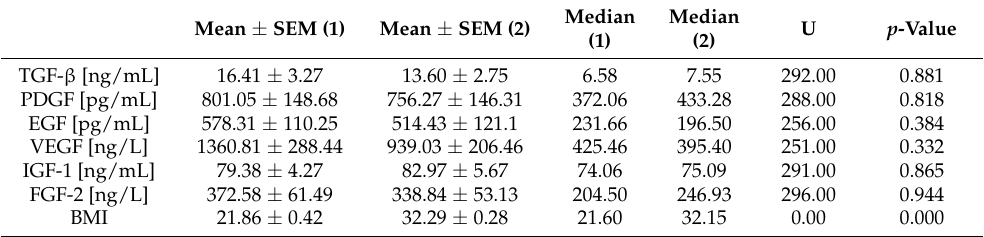
Table 3. Statistical data for both groups (1 - control and 2 - study): mean ± SEM, median, and U Mann-Whitney test’s U and p